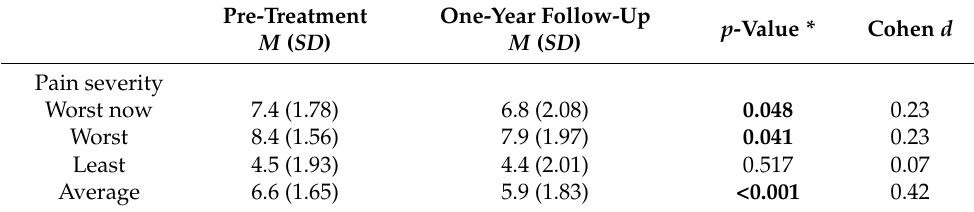
Table 2. Pain severity ( n =